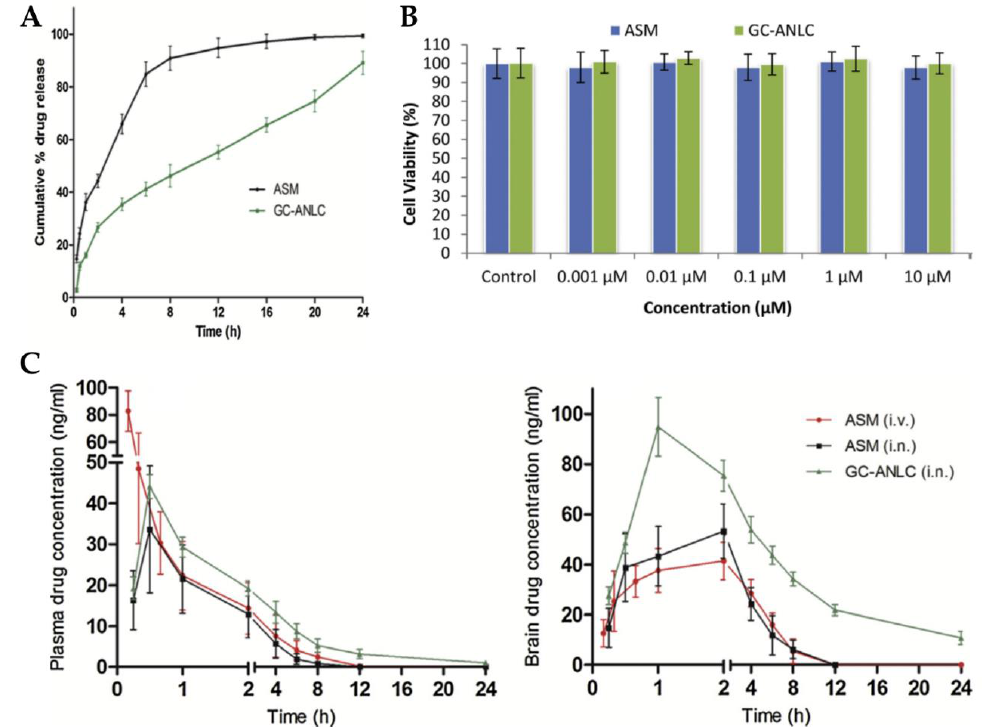
Figure 5. ( A ) In vitro drug release profile of the developed asenapine NLC (“GC-ANLC”) and a drug solution (“ASM”); ( B ) Cell viability results (A549 cells) of the developed asenapine NLC (“GC-ANLC”) and a drug solution (“ASM”); ( C ) Plasma (left) and brain (right) drug concentration vs time profiles of the developed asenapine NLC after IN administration [“GC-ANLC (i.n.)”], and after IV [“ASM(i.v.)] or IN [“ASM(i.n.)] administration of a drug solution; adapted from Singh et al. [105],